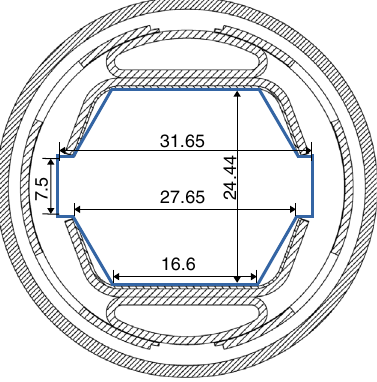
FIG. 5. Cross section of FCC-hh beam screen, adapted from [49], values are given in mm. The blue line displays the implementation in MAD - X .